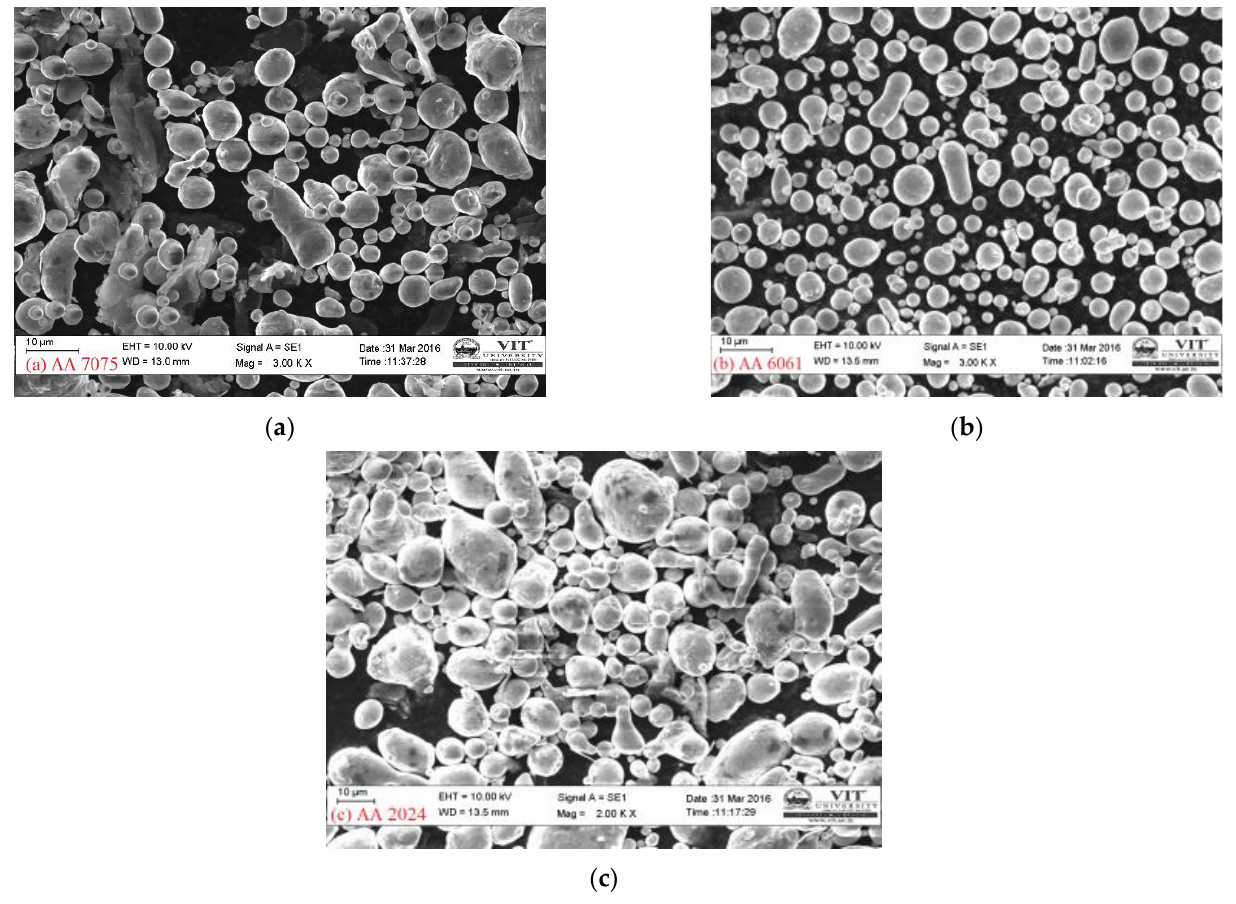
Figure 8. FESEM pictures of received ( a ) AA 7075, ( b ) AA 6061, ( c ) AA 2024.